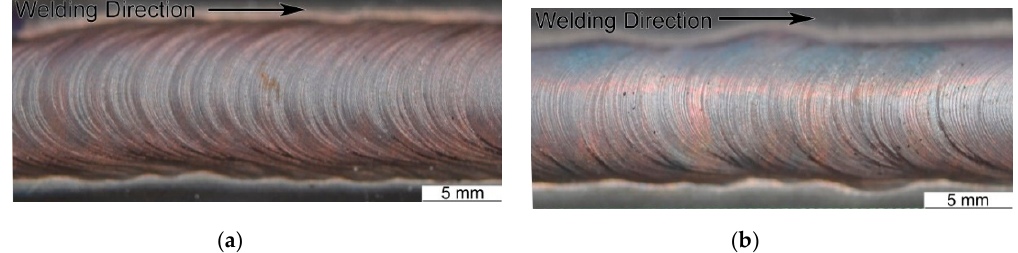
Figure 3. The appearances of welds by: ( a ) gas tungsten arc welding (GTAW) and ( b ) gas tungsten arc welding (GTAW) + electromagnetic stirring (EMS).